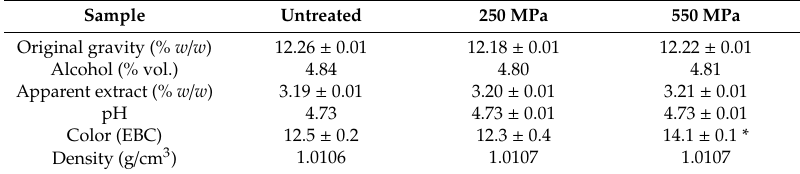
Table 1. Physico-chemical parameters of beers after high-pressure processing (HPP) at different pressures.